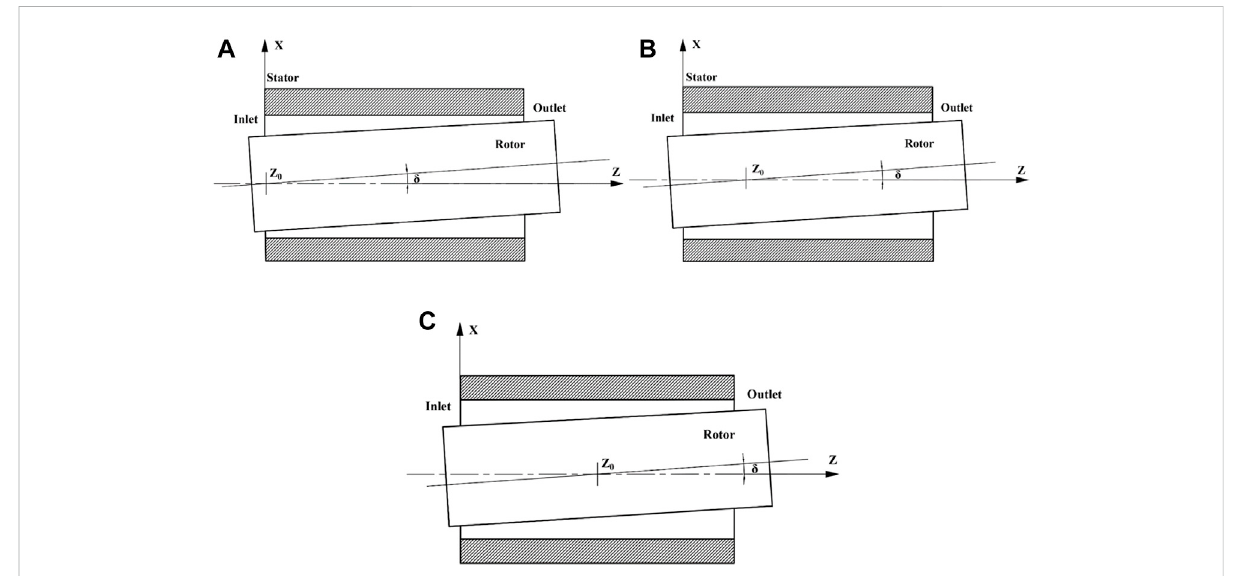
FIGURE 2 The diagram of three misalignment modes of the annular seal: (A) Mode 1; (B) Mode 2; (C) Mode 3.